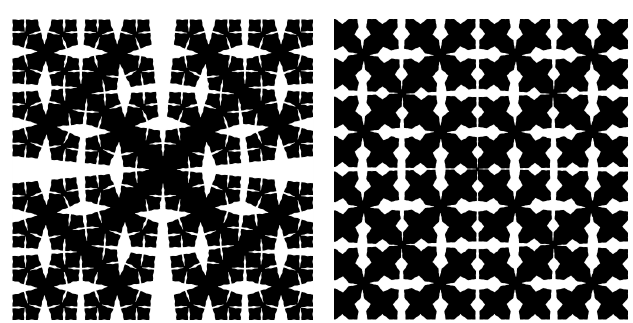
Figure 5. Inward